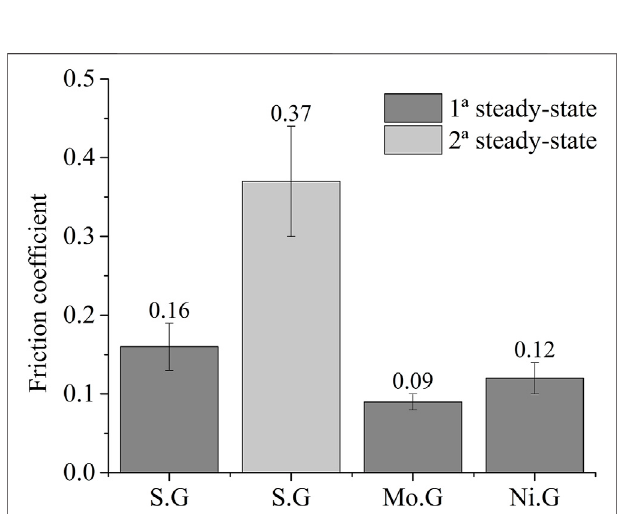
FIGURE 10 | Average steady-state COF (error bars show standard deviation).